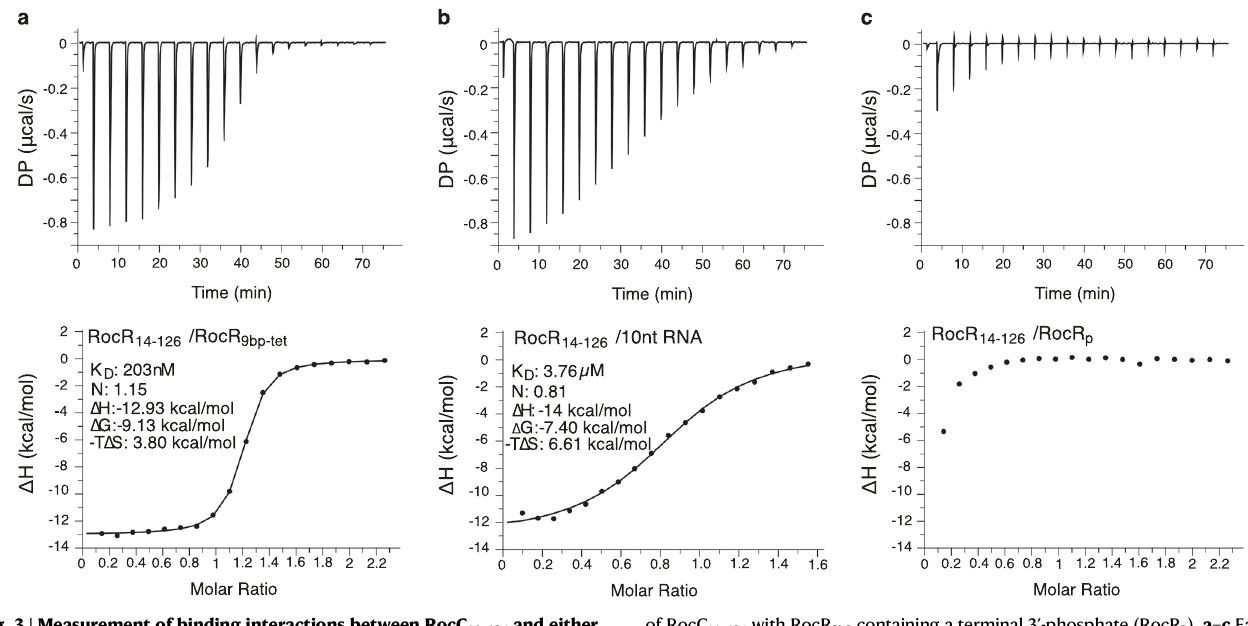
of RocC 14 − 126 with RocR SL3 containing a terminal 3 ’ -phosphate (RocR P ). a – c Each experiment was repeated independently three times with similar results. Source data are provided as a Source Data fi